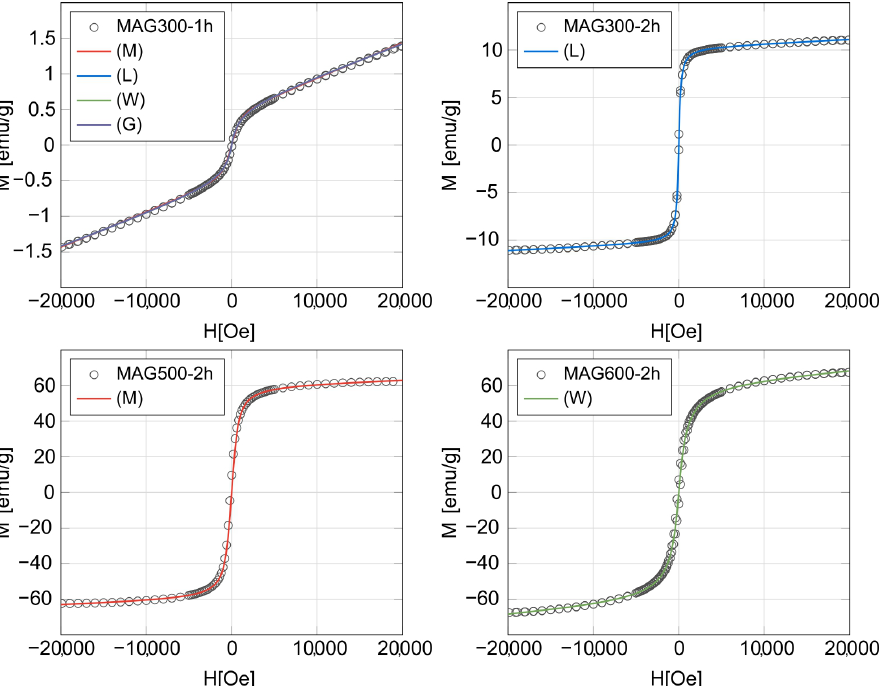
Figure 1. Fittings to the magnetization curves of the Mag300-1h, Mag300-2h, Mag500-2h and Mag600- 2h samples using the models (M) Modified Langevin function, (L) lognormal, (G) gamma and (W) Weibull. For each sample, the fitted curves are very similar. For this reason we only show the best-fitted curve for the last three samples, i.e., the model which has the lowest Akaike information criterion (AIC) value. Experimental measurements were performed at room temperature (300 K).